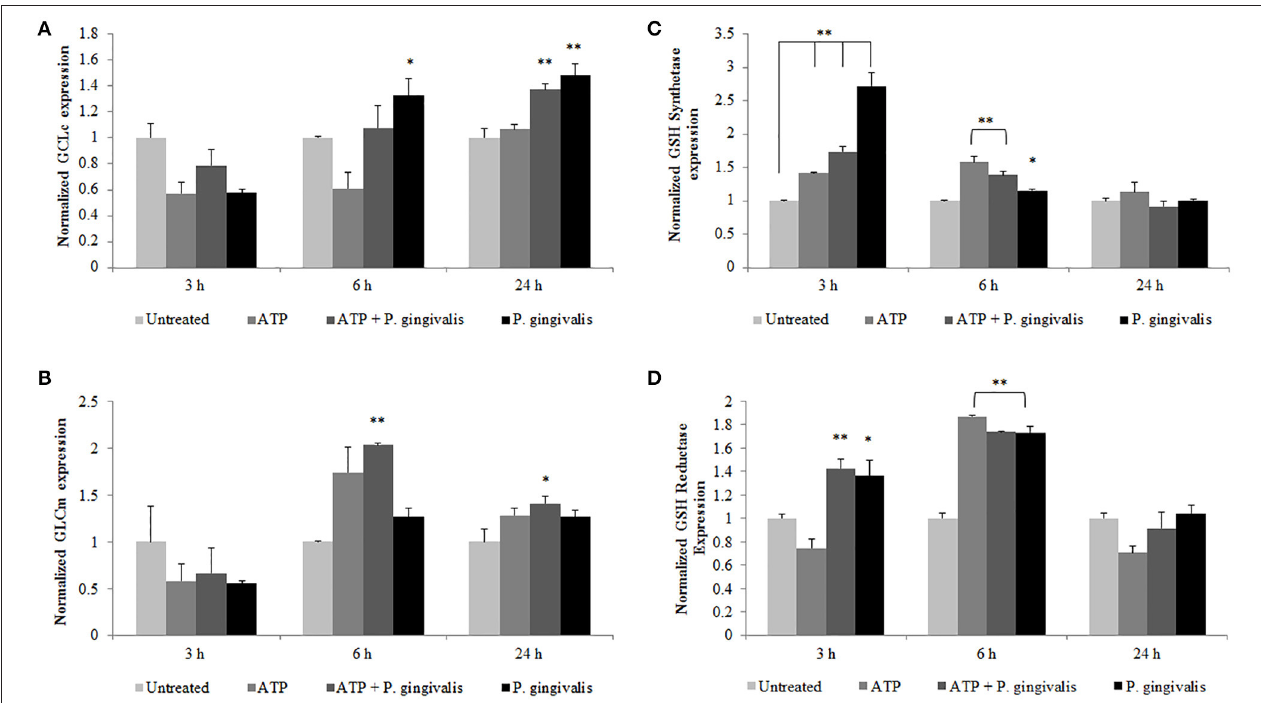
FIGURE 8 | P. gingivalis temporally modulates the expression of vital host glutathione renewal and synthesizing enzymes during infection. Primary GECs pre-treated with (3 mM) ATP and infected with P. gingivalis (MOI100) for the specified time points were analyzed by quantitative PCR using SYBR Green for mRNA levels of